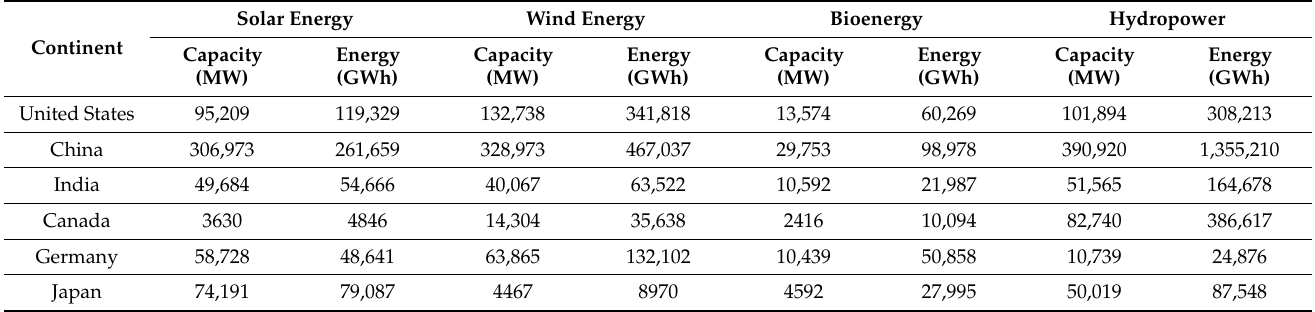
Table 5. Renewable energy installed capacities and electricity production in the most contributed countries